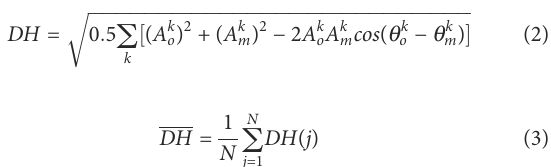
Table 1. The correlation coef fi cients between the simulated amplitudes of M 2 , S 2 , K 1 , and O 1 tides and observations from altimeter cross points in EXP 1-3 are larger than 0.92, 0.88, 0.88, and 0.91, respectively. The correlation coef fi cients between the simulated phase lags of M 2 , S 2 , K 1 , and O 1 tides and observations from altimeter cross points in EXP 1-3 are larger than 0.89, 0.95, 0.95, and 0.85, respectively. For the amplitude, the relative bias of the M 2 , S 2 , K 1 , and O 1 constituents between the observed and simulated harmonic constants in EXP 1-3 are smaller than 4.3%, 5.2%, 4.8%, and 4.9%, respectively. For the phase lag, the relative bias of M 2 , S 2 , K 1 , and O 1 constituents in EXP 1-3 are smaller than 6.3%, 3.2%, 3.7%, and 6.2%, respectively. The DH between the simulated results and observations from satellite altimeters of M 2 , S 2 , K 1 , and O 1 tides are (10.7, 15.7, 17.7, 17.4 cm) in EXP 1, (11.4, 15.7, 17.3, 18.0 cm) in EXP 2, and (10.5, 15.2, 17.2, 16.1 cm) in EXP 3. According to the calculations of the average absolute differences, correlation